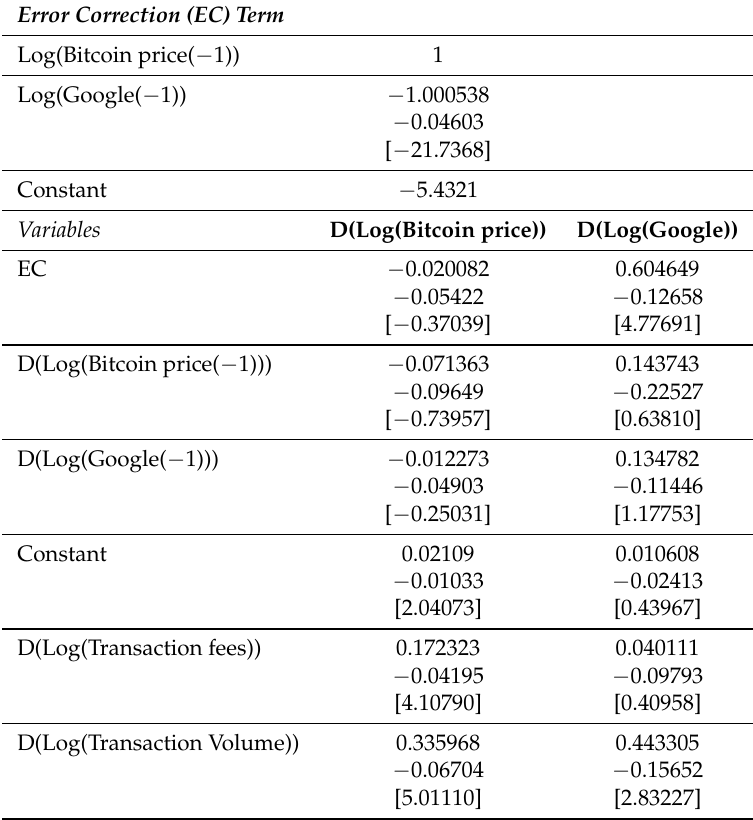
Table A7. VECMX(1) for Log(Bitcoin price) and Log(Google), with Log(transaction volume) and